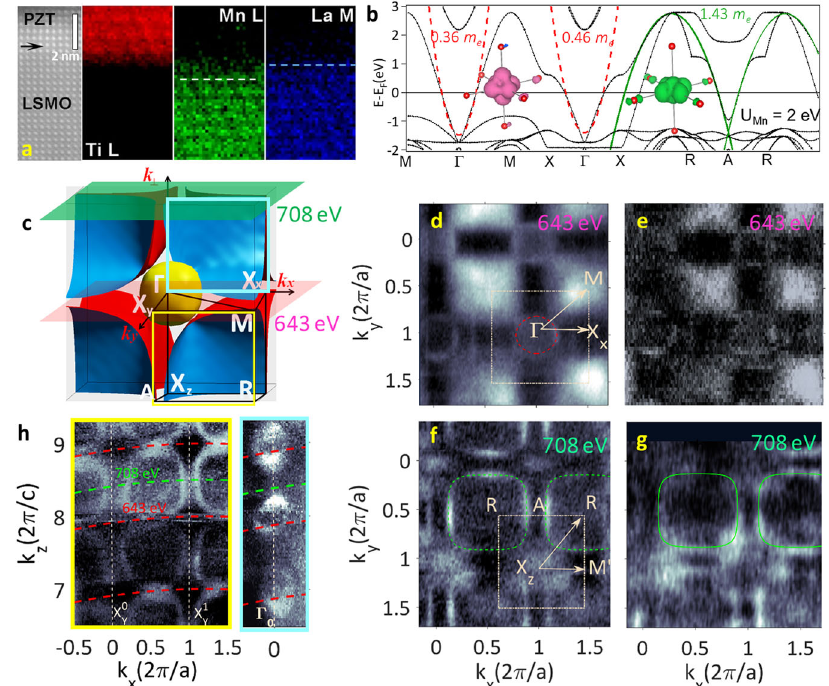
Fig. 1 Structural and electronic properties. a High resolution high-angle annular dark- fi eld scanning transmission electron microscopy image at the PbZr 0.2 Ti 0.8 O 3 -La 0.7 Sr 0.3 MnO 3 (PZT|LSMO) interface, and Ti L, Mn L and La M maps at atomic level. The black arrow indicates the fi rst ferroelectric unit cell ( b ) Theoretical Hubbard U - corrected density functional theory band structure for SrTiO 3 -strained pseudocubic LSMO and (insets) local density of states integrated ± 0.2 eV around the Г and A bands bottom. ( c ) Calculated Fermi surface (FS) for strained LSMO. d , e In-plane FS maps for respectively bare LSMO and BaTiO 3 (BTO) interface, LSMO|BTO in the Г MX planes recorded with hv = 643 eV. f , g In-plane FS maps for respectively bare LSMO and BaTiO 3 (BTO) interface, BTO|LSMO in the X Z AR.plane recorded with hv = 708 eV. h Experimental out-of-plane FS maps for the BTO| LSMO heterostructure in the X Y MR and Γ XxXz planes. Colored frames enclosing the out-of-plane FSs encode the probed planes with the corresponding colors from ( c